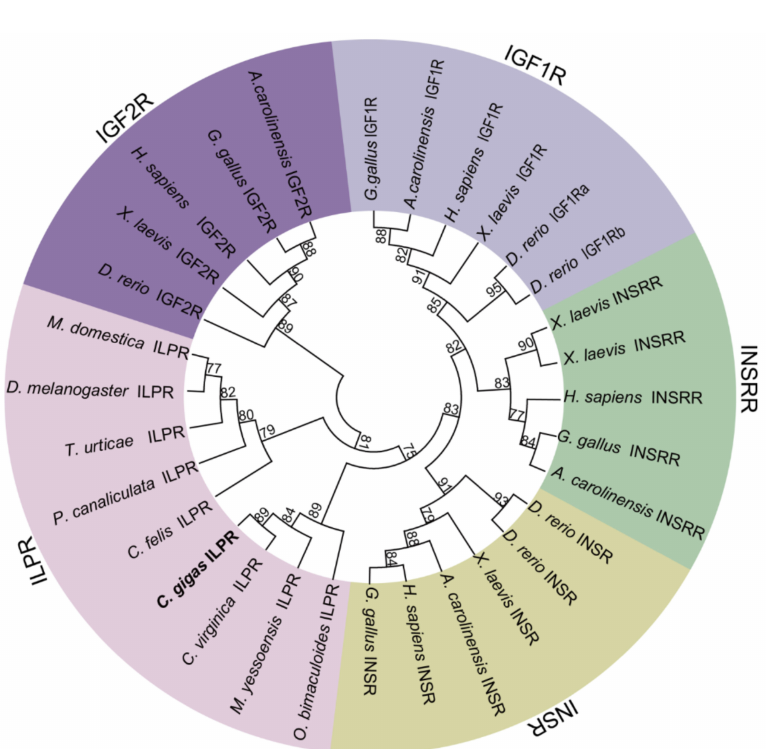
Figure 1. Phylogenetic analyses of the insulin receptors and insulin-like peptide receptors. The amino acid sequences of the insulin receptors and insulin-like peptide receptors from Homo sapiens , Gallus gallus , Xenopus laevis , Anolis carolinensis , Danio rerio , Drosophila melanogaster , Musca domestica , Cteno- cephalides felis , Mizuhopecten yessoensis , Tetranychus urticae, Octopus bimaculoid , Pomacea canaliculata , Crassostrea virginica, and Crassostrea gigas were retrieved from the NCBI database. The phylogenetic tree was constructed using the neighbor-joining (NJ) approach in MEGA7. The reliability of the topological structure was tested using 1000 bootstrap